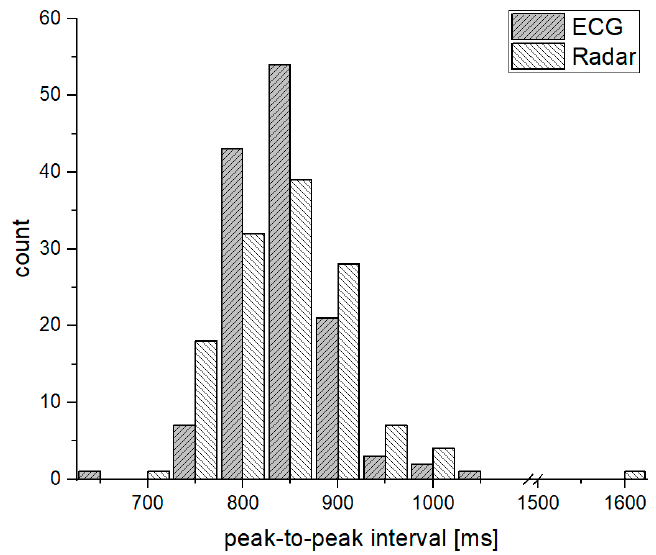
Figure 2. Histogram of the peak-to-peak interval for the measured ECG and radar signals.